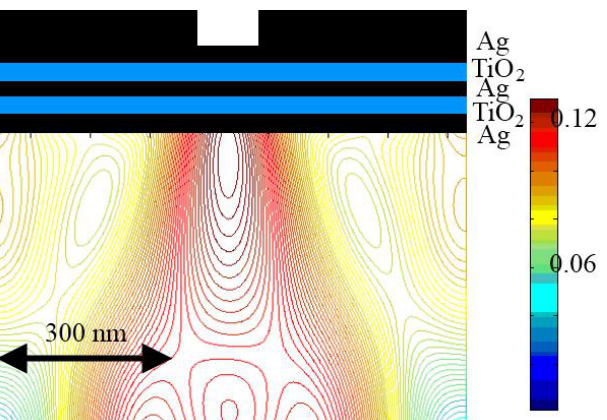
Figure 4: Distribution of module of electric field after passing through hyperbolic metamaterial with index of dielectric layers n(TiO 2